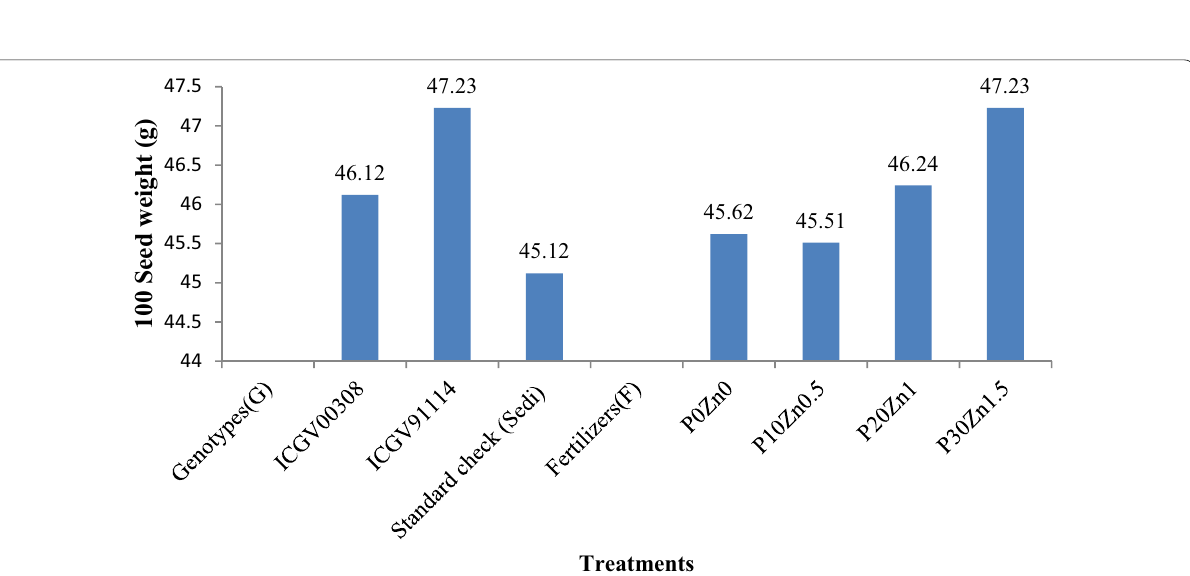
Fig. 4 Main effect of genotypes and PZn on hundred seed weight of groundnut